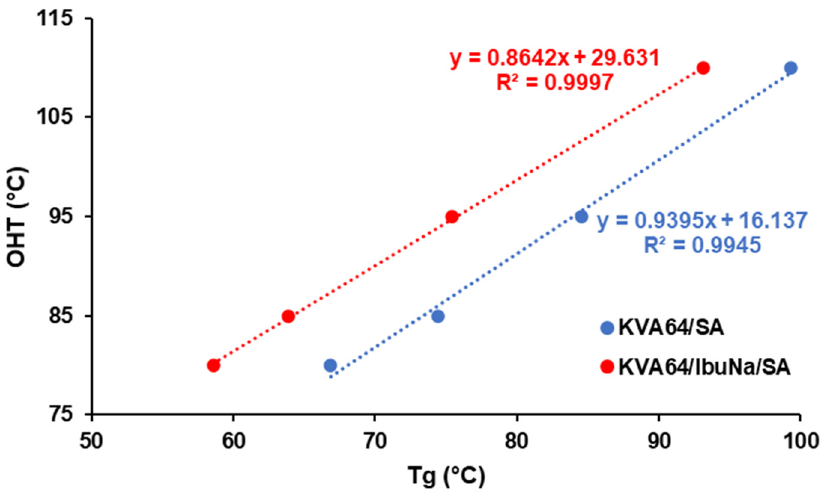
Figure 2. Relationship between glass transition temperatures and optimal heating temperatures at different ratios of succinic acid for mixtures of KVA64/SA and mixtures of KVA64/IbuNa/SA.